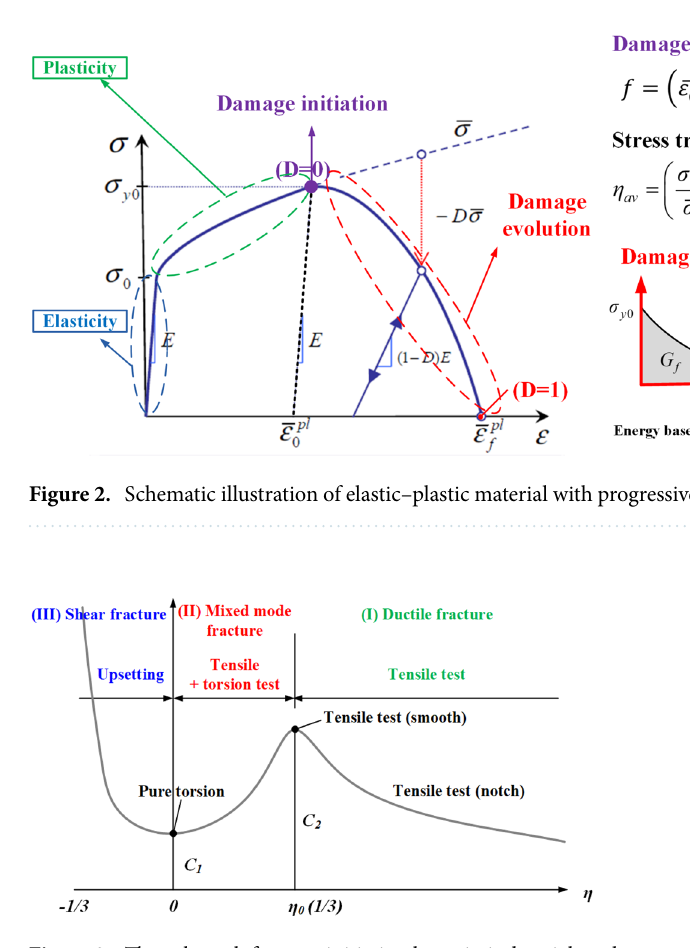
Figure 3. Three-branch fracture initiation locus in industrial